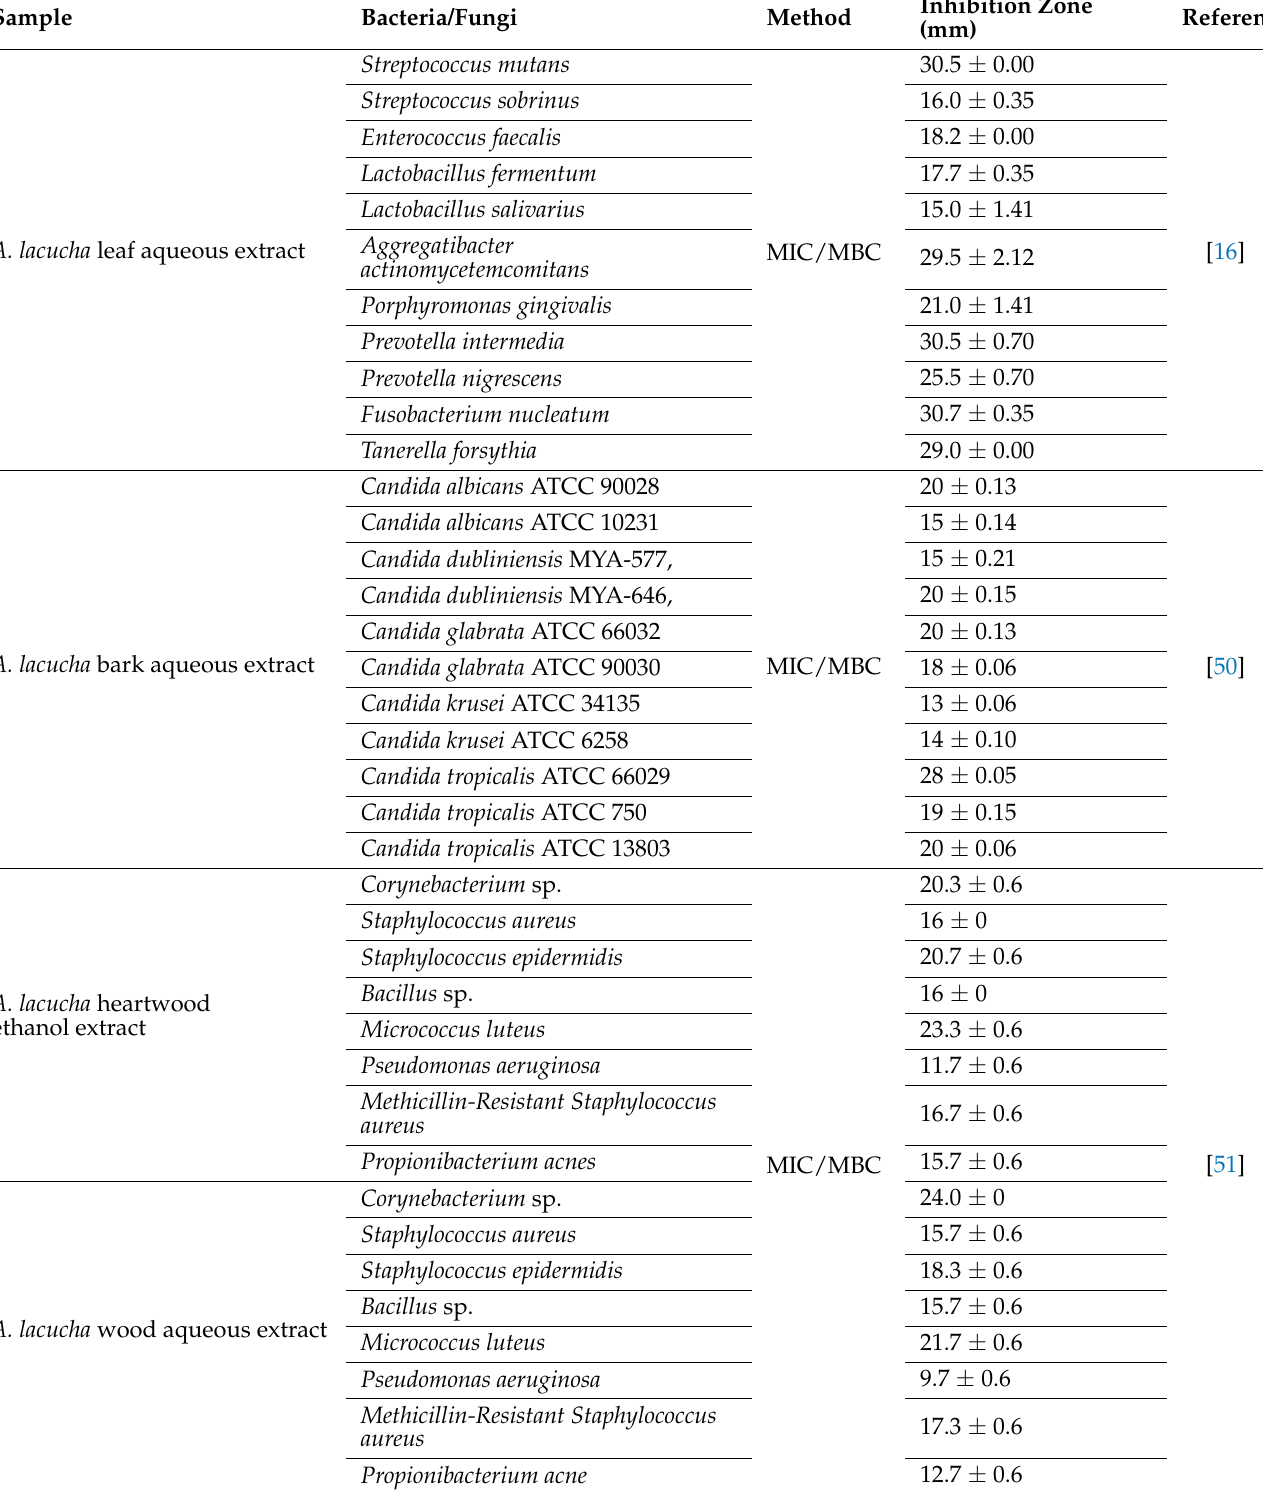
Table 3. Antimicrobial activity of A. lacucha